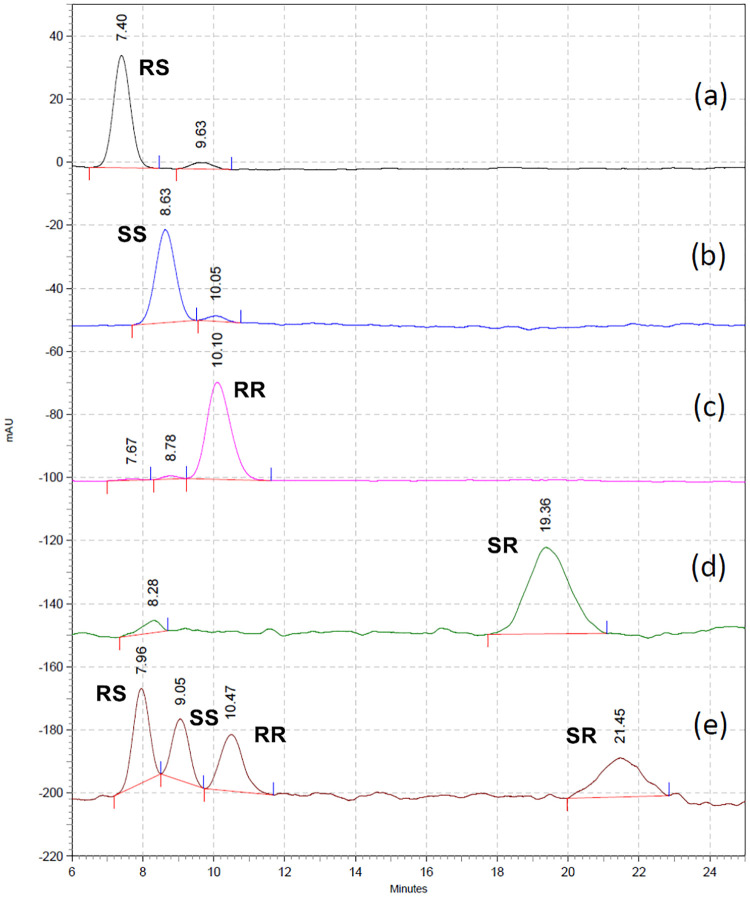
Chiral HPLC chromatograms.Using Chirex 3126 column: 30 mm × 4.6 mm; mobile phase: MeCN:2 mM CuSO4 = 15:85; at 22°C. (a) (2R,4S)-1; (b) (2S,4S)-1; (c) (2R,4R)-1; (d) (2S,4R)-1; (e) a mixture of four FSPG stereoisomers.